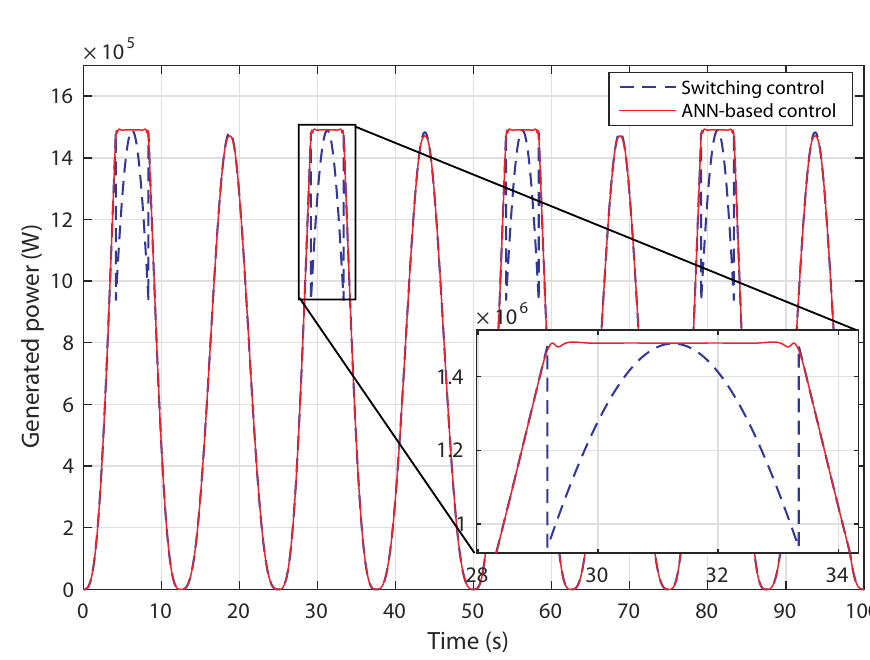
Figure 16. Scenario 1: generated active power